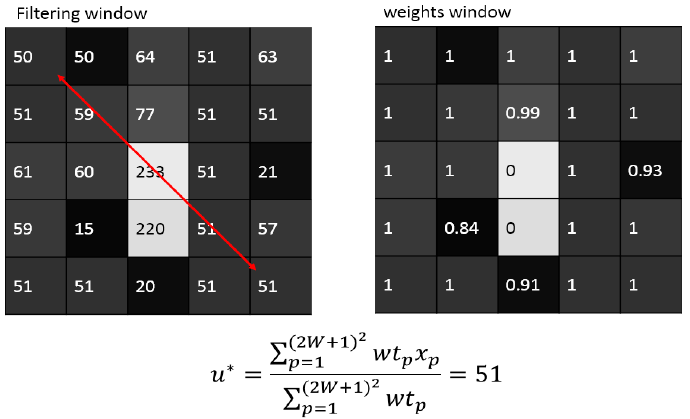
Figure 9. Repair of darker areas ( u * = 51).